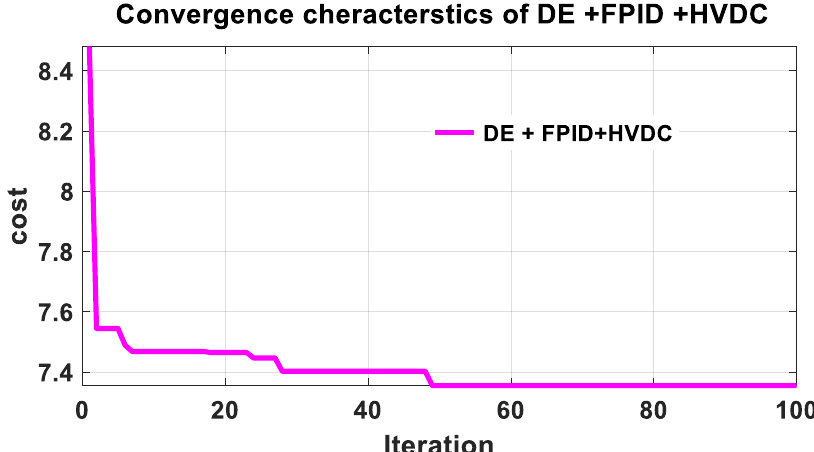
Figure 14. Convergence characteristic for DE + FPID+HVDC.